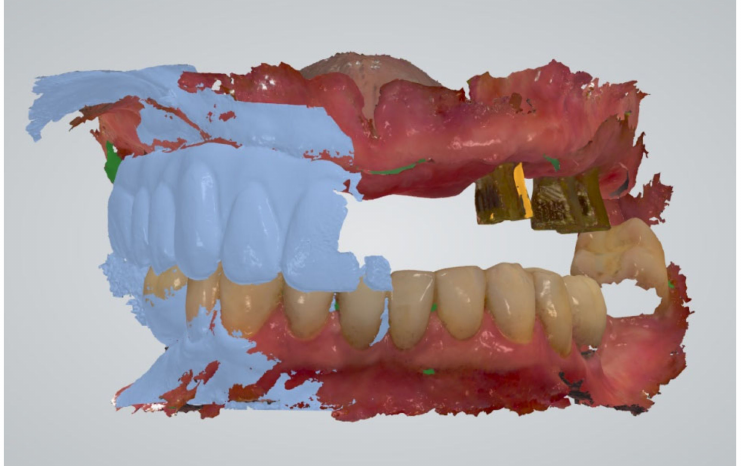
Figure 5. The bite registration was performed with two buccal bite-scans tracing the full-arch maxillary fixed implant prosthesis and the mandibular antagonist arch (3Shape Dental Desktop 1.7.9.1, 3Shape, Copenhagen, Denmark). Consequently, the scan body positions are linked to the original maxillomandibular relationship as determined by the analog bite